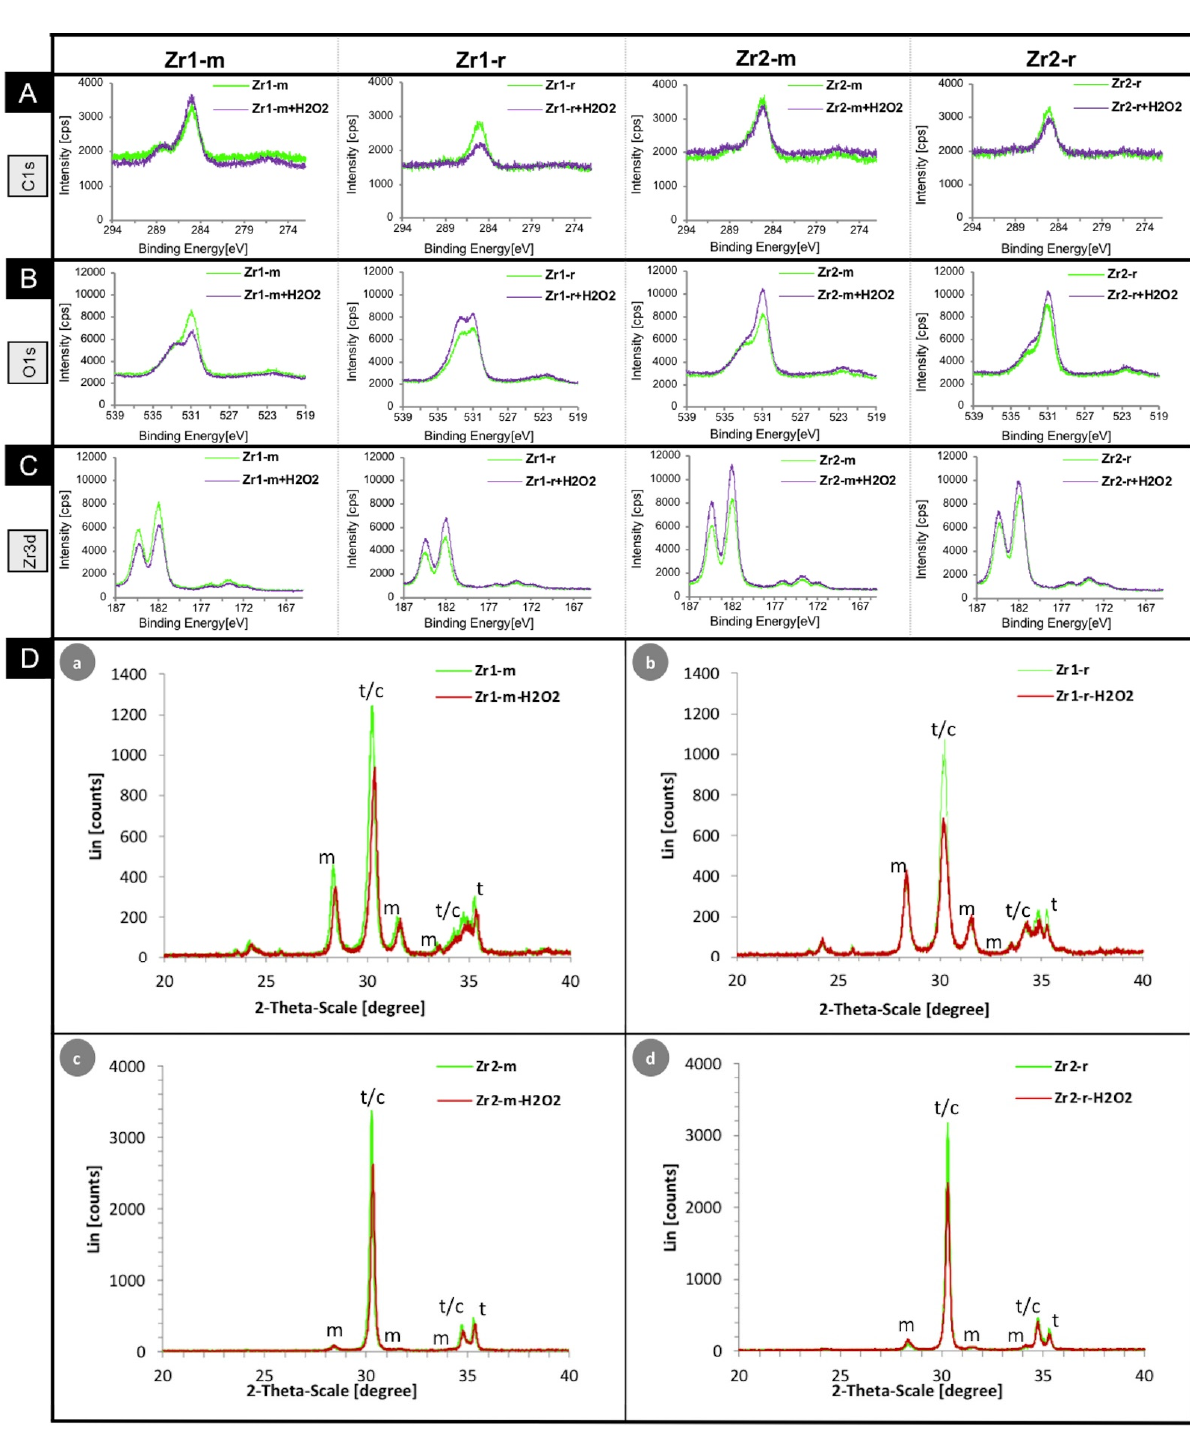
Figure 2. ( A – D ) XPS detail spectra of the smooth and roughened surfaces of the two zirconia materials (Zr1-m/r and Zr2-m/r) and changes in the chemical composition after H 2 O 2 -treatment for the following electrons: ( A ) = C1s; ( B ) = O1s; ( C ) = Zr3d. ( D ) XRD graphs of the four surfaces (a/b: Zr1-m/r and c/d: Zr2-m/r) (t = tetragonal ZrO 2 , m = monoclinic ZrO 2 ; c = cubic phase). Typical peaks of the monoclinic ZrO 2 phase at 2 θ of 28.3 ◦ and 31.5 ◦ and peaks of the tetragonal/cubic phase at 2 θ of 30.3 ◦ were detected on all surfaces. Additional specific peaks for the tetragonal phase could be identified, but they overlapped the cubic phase peaks. The surface of the Zr1 material showed several additional peaks indicative of additional crystalline